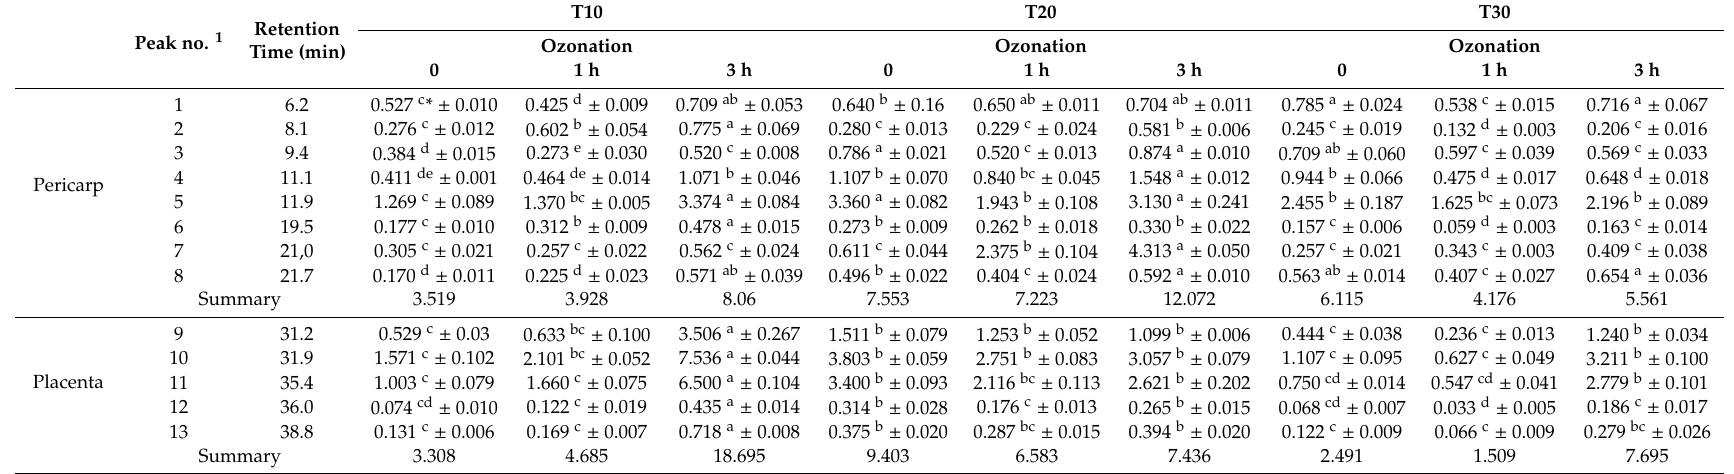
Table 1. Content of phenolic compounds (quercetin-3- O -rhamnoside equivalent mg / 100 FM) in pericarp and placenta of pepper fruit as a ff ected by ozonation and